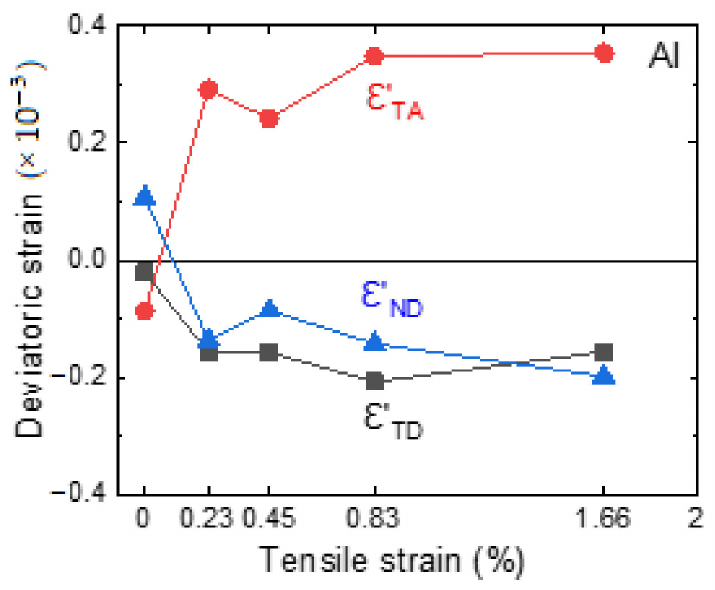
Figure 6. The evolution of the average deviatoric strains ( ε (cid:48) TD , ε (cid:48) TA and ε (cid:48) ND ) in the Al layer during tensile loading. The magnitude of the standard deviation is in the order of 10 − 3 . The 0.2% offset yield point strain for Al is about 0.23%.